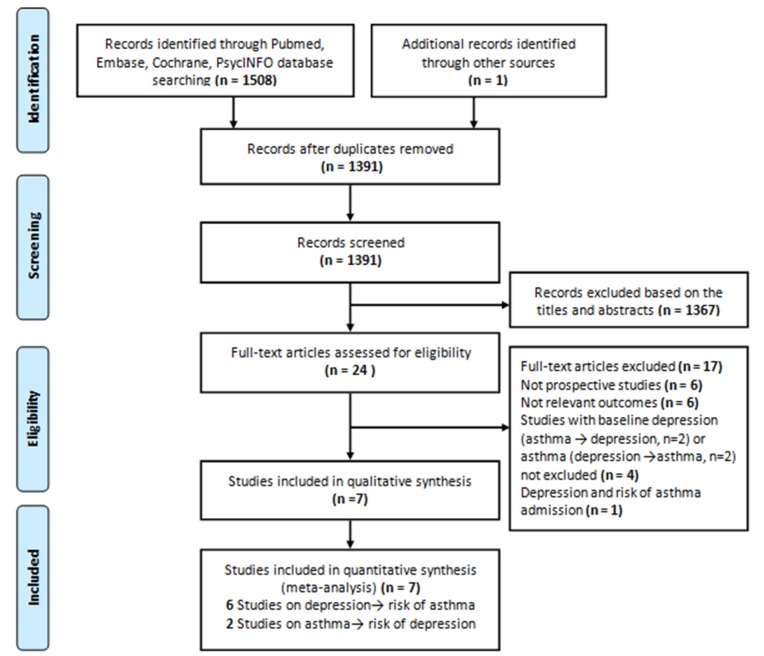
Flow chart showing the procedure for identifying the studies that were included in the meta-analysis.